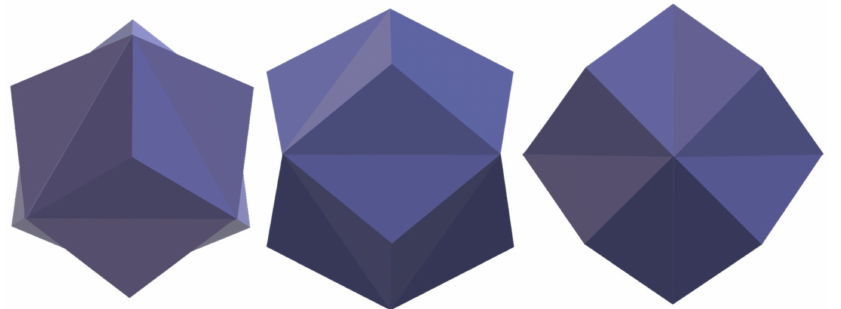
Figure 7. Model of trisoctahedron gold nanoparticles formed by the seed-mediated growth